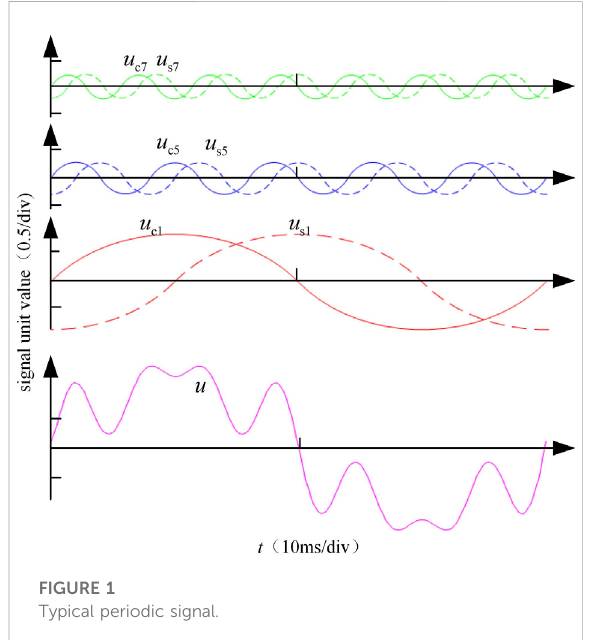
FIGURE 1 Typical periodic